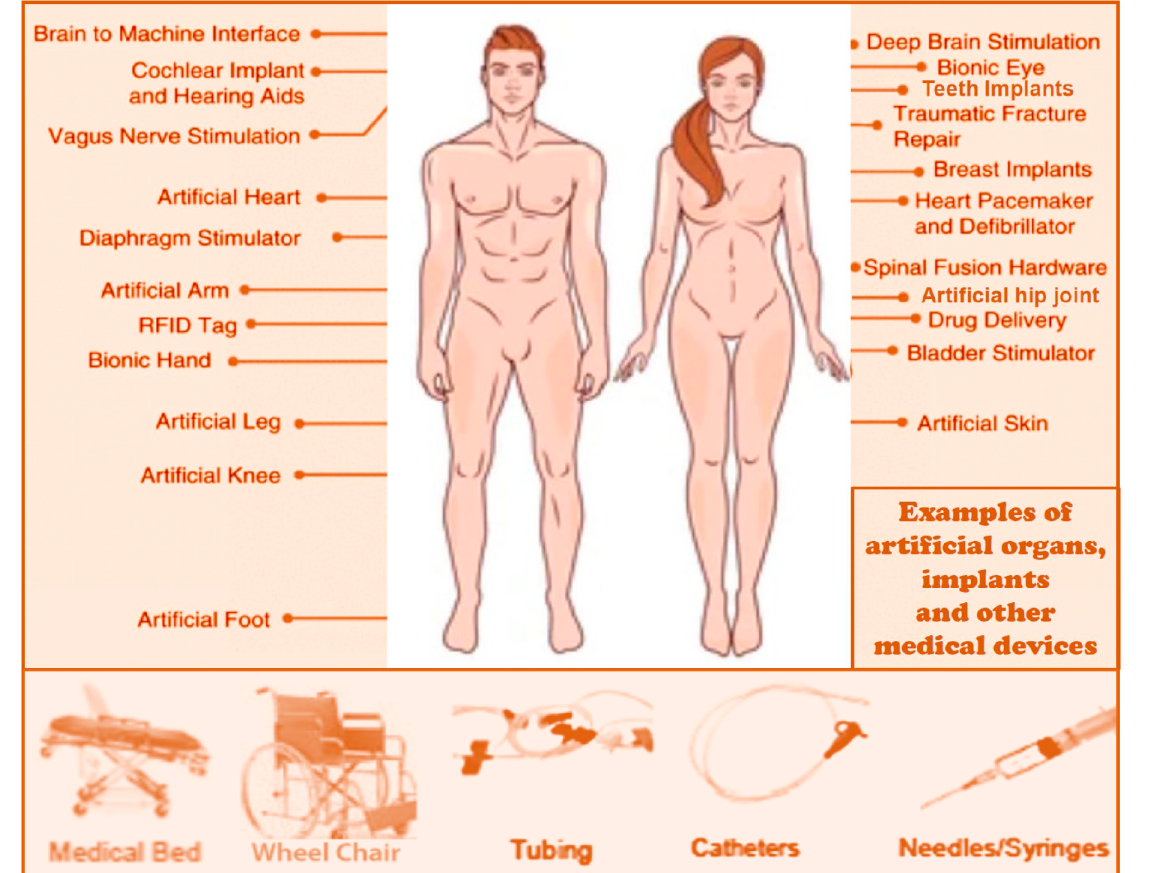
Figure 17. Examples of artificial organs, implants, and other medical devices to replace various tissues and organs of the human body and medical care.